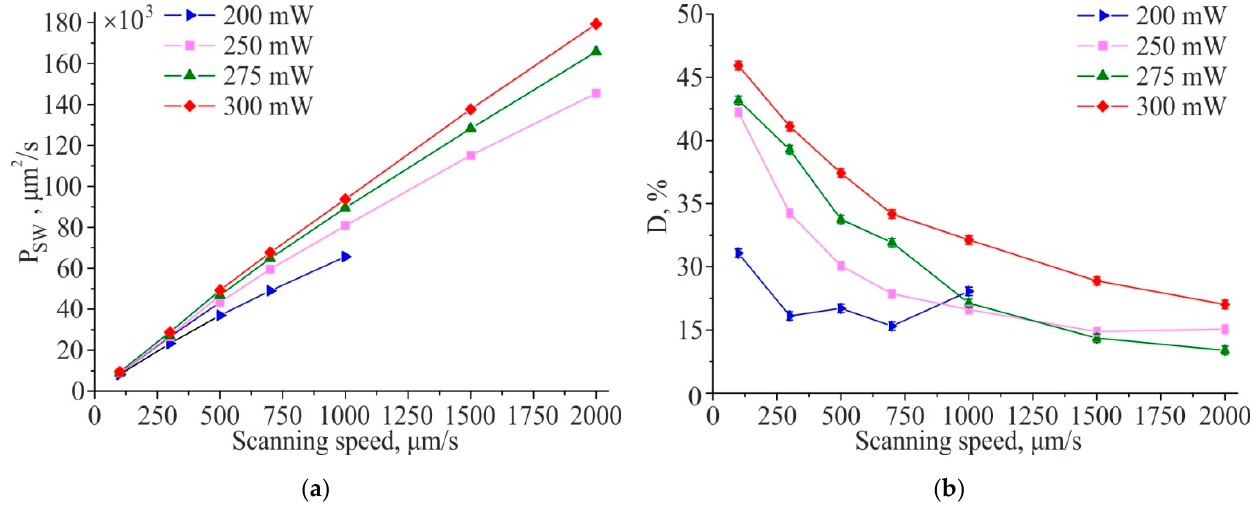
Figure 7. Productivity of TLIPSS formation on a hafnium film in a low vacuum ( a ) and relative area of defects ( b ) at different scanning speeds and laser powers.